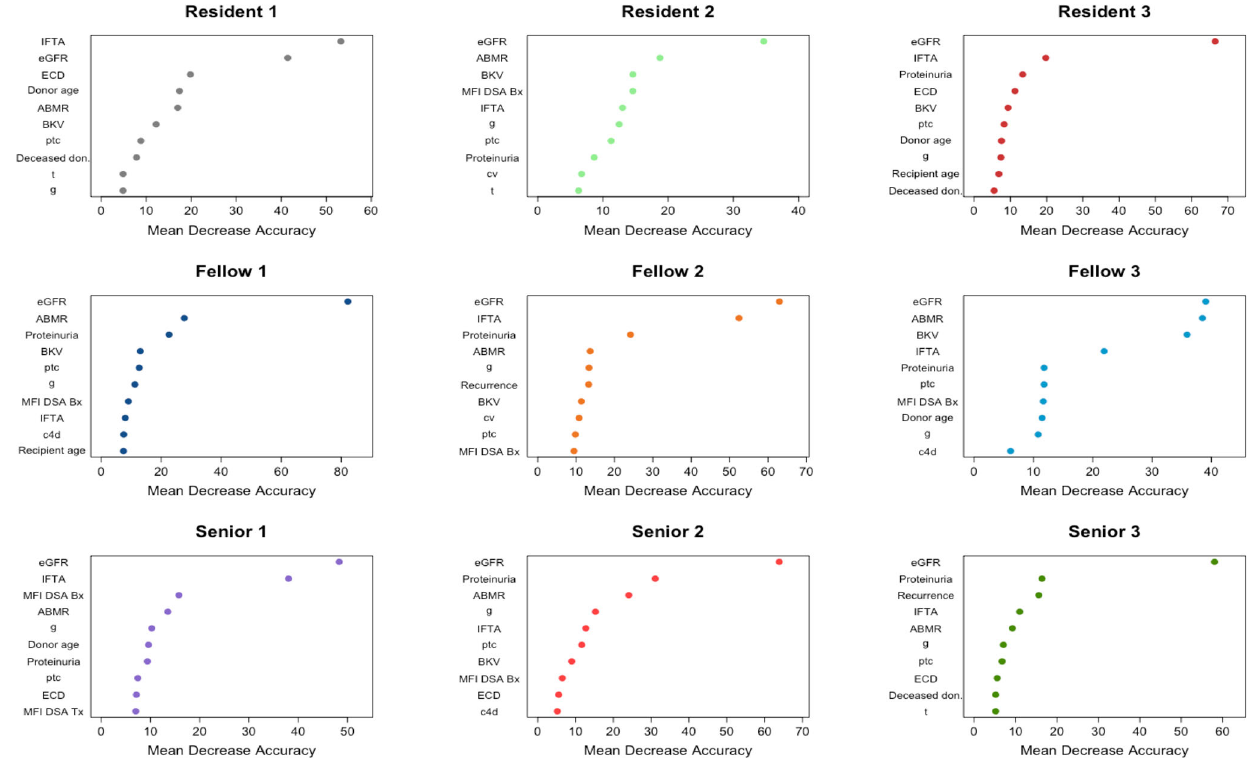
Fig. 4 Ranking of the ten most important features driving the physicians ’ predictions. n = 400 patients and nine transplant physicians. We ranked the features importance for each physician based on the mean decrease accuracy from each physicians ’ Random Survival Forest. Each plot expresses how much accuracy is lost in the prediction by excluding each parameter. The features are presented from descending importance. The higher the value of mean decrease accuracy, the higher the importance of the feature in the model. The cg and i Banff scores were not found in any physicians; the t Banff score was found in 3 (33%) physicians and the MFI of the immunodominant anti-HLA DSA was found in 6 (66%) physicians. ABMR antibody mediated rejection, i interstitial in fl ammation Banff score, t tubulitis Banff score, g glomerulitis Banff score, ptc peritubular capillaritis Banff score, cv arterial intimal